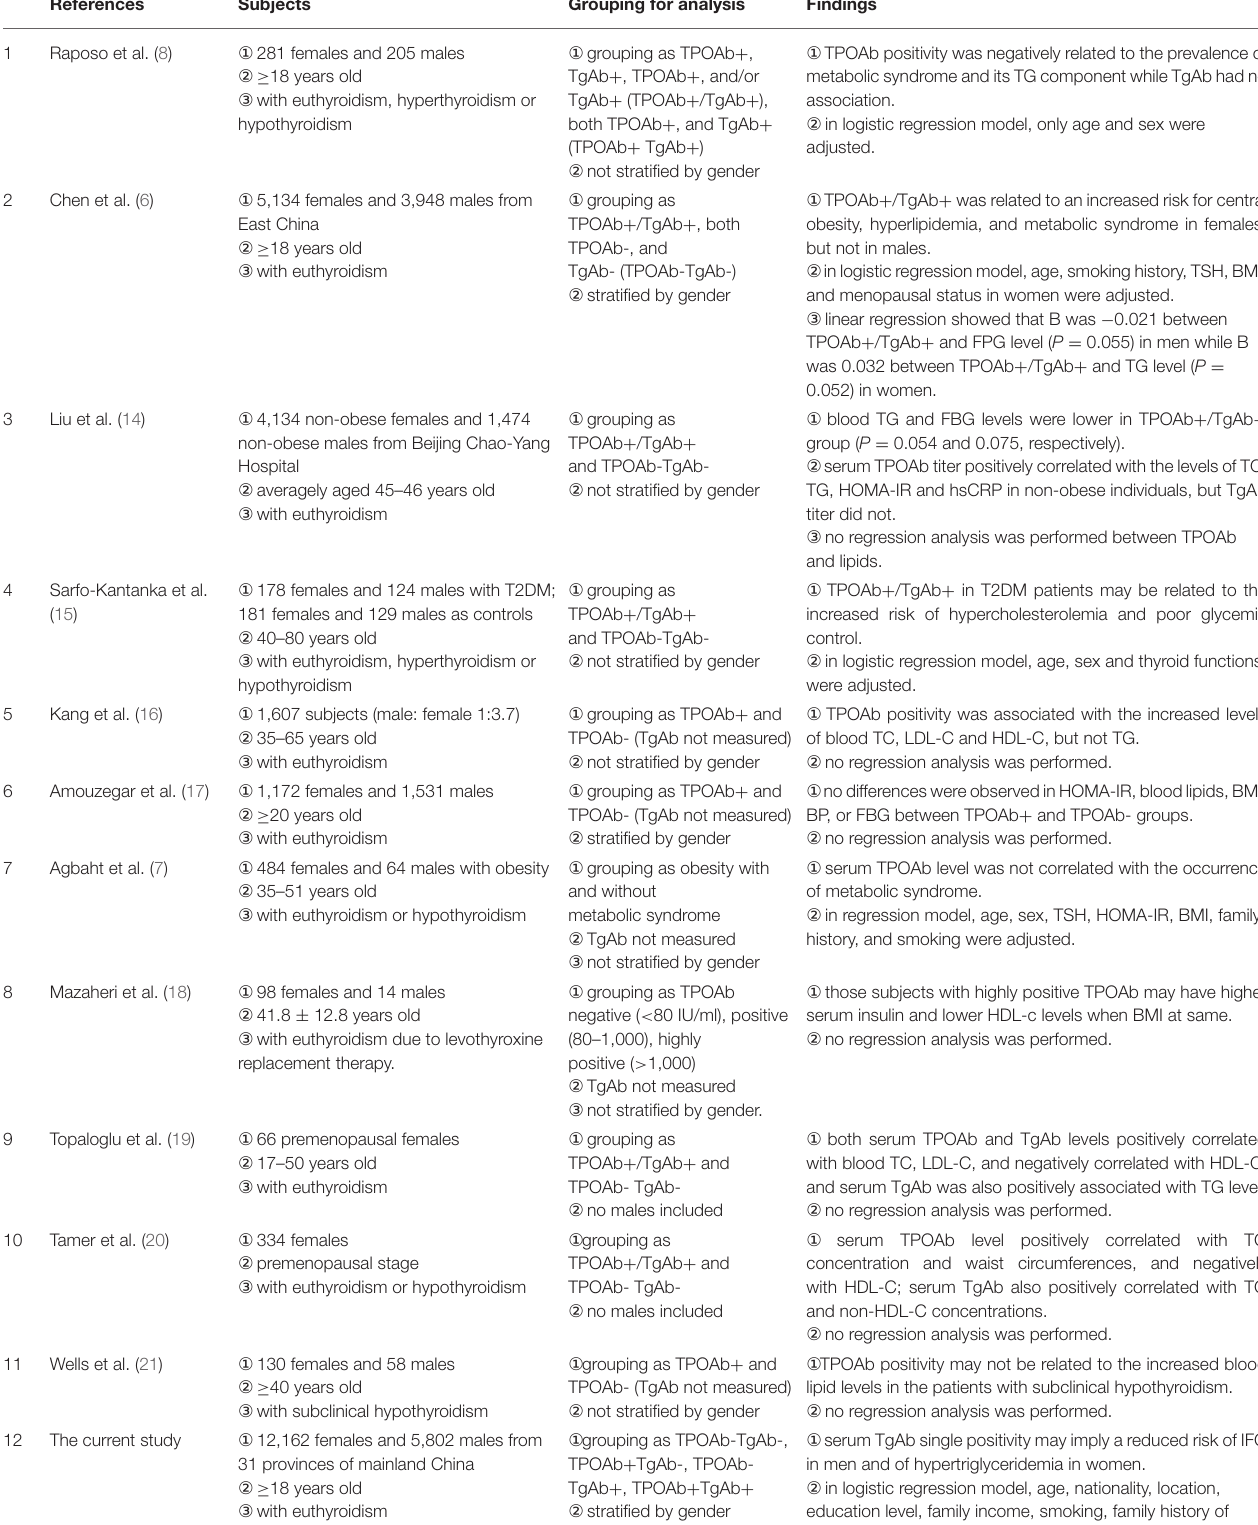
TABLE 5 | Summary of the studies related to TPOAb, TgAb, and metabolic disorders of glucose and